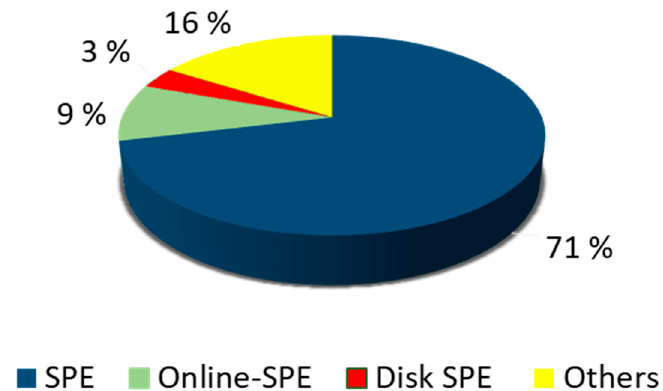
Figure 1. Pharmaceuticals and personal care products (PPCPs) extraction procedures according to the percentage of studies that applied them. SPE: solid-phase extraction.